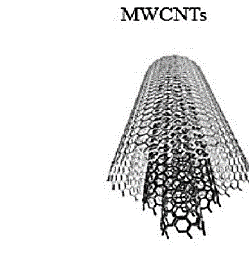
Figure 10. Different types of CNTs adsorbents. Reproduced with permission from [107] .